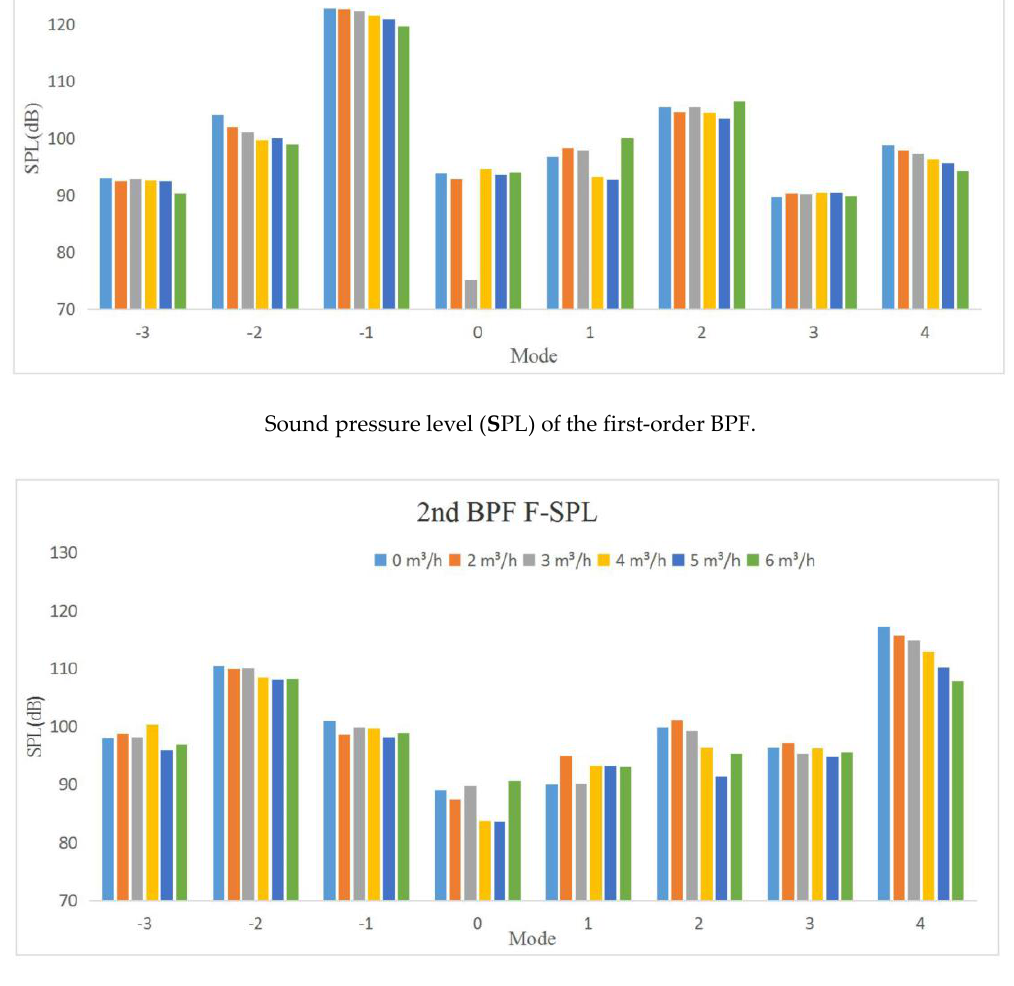
Figure 8. SPL of the first and second-order BPF.